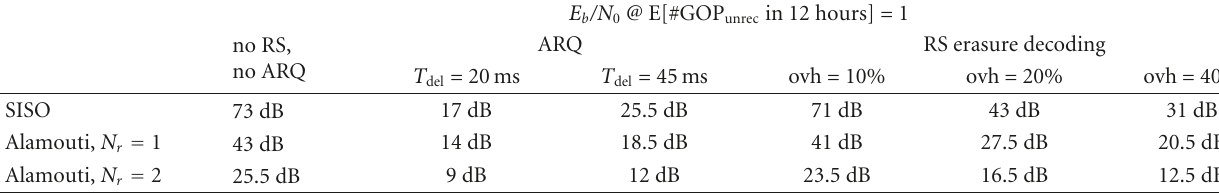
Table 2: Value of E b /N 0 yielding 1 GOP with unrecoverable packet loss per 12 hours.